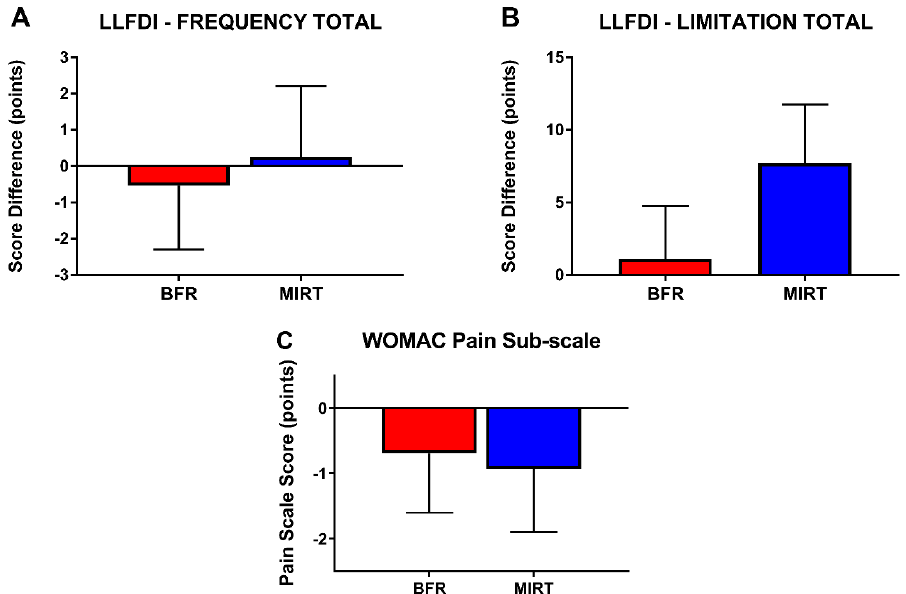
Figure 3. ( A–C ) Subjective measures of pain and function were evaluated from baseline to week 12 via reported the group mean difference for Late Life Functional and Disability Instrument (LLFDI) Total Disability Frequency ( A ), Total Disability Limitation ( B ) where a higher reported score represents better performance, and WOMAC pain sub-scale ( C ). Values indicate estimated marginal mean ± SEM. Abbreviations: BFR—blood-flow restriction, MIRT—moderate-intensity resistance training, WOMAC—Western Ontario and McMaster Universities Osteoarthritis